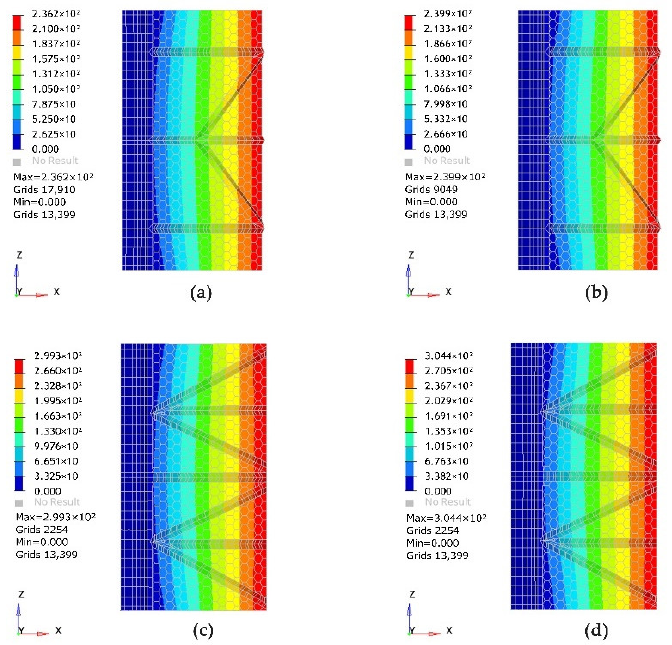
Figure 20. ( a ) Linear combined displacement analysis of carport I model under the load of 1.2 G k + 1.4 × 0.85 Q S + 1.4 Q W ; ( b ) Nonlinear combined displacement analysis of carport I model un- der the load of 1.2 G k + 1.4 × 0.85 Q S + 1.4 Q W ; ( c ) Linear combined displacement analysis of